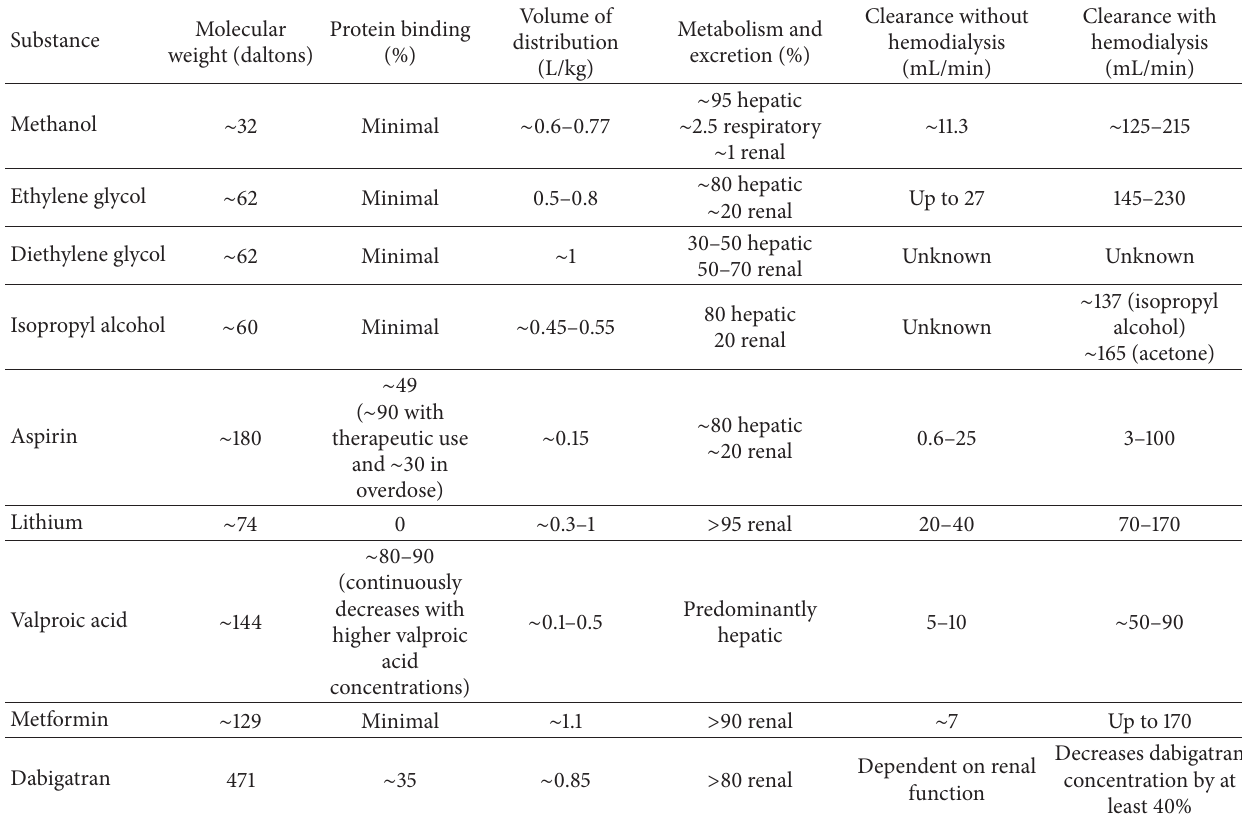
Table 3: Summary of pharmacological and clearance properties of some pharmacological substances ∗ .